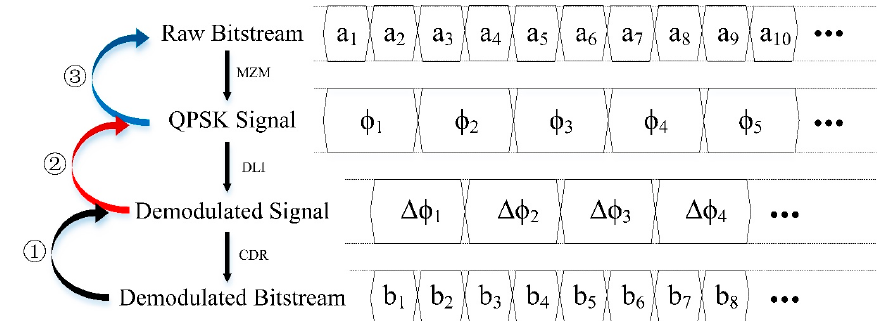
Figure 3. The conversion diagram of the signal flow. The phases of the QPSK signal correspond to the dual-bit symbols of a raw bitstream after modulation. The output of the DLI is the phase difference between adjacent symbols of the QPSK signal. The dual-bit symbols of a demodulated bitstream correspond to the differential phases of a demodulated signal.